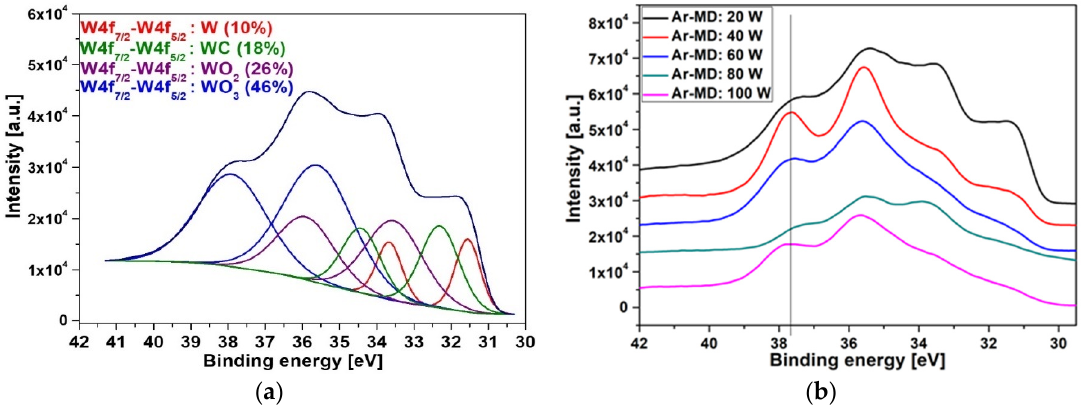
Figure 19. XPS analysis of the obtained particles in Ar-MD configuration: The influence of input power upon W4f zone: ( a ) W4f deconvolution of Ar-MD at 20 W; ( b ) W4f zone of Ar-MD for 20 W–100 W.